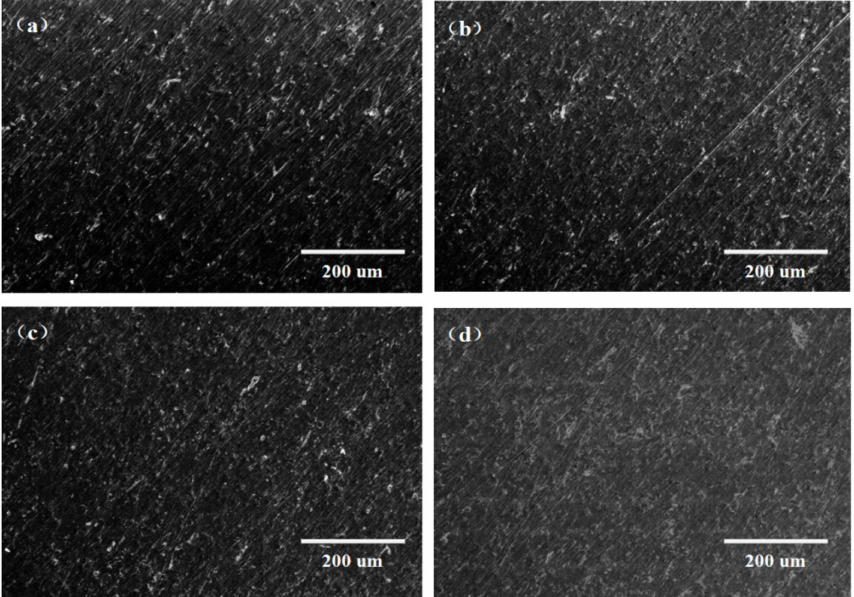
Figure 1. Surface morphology (magnification 500X) of different samples: ( a ) Ti-UV; ( b ) Ti-0.2; ( c ) Ti-0.5; ( d ) Ti-1.0.